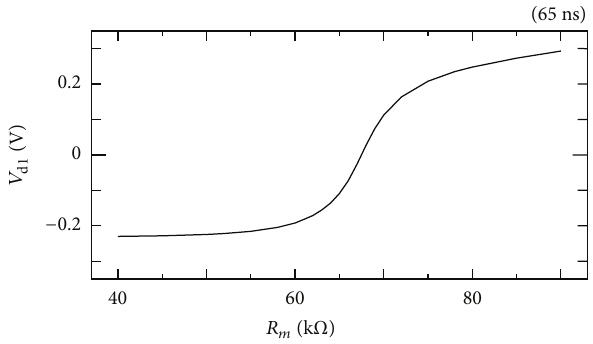
Figure 13: Effect of 𝑅 𝑚 fluctuations. 𝑉 shows the different voltage d1 = 𝑉( S 1)−𝑉( S 2) ). 𝑅 between the node S1 and S2 ( 𝑉 𝑚 was compared d1 , and 𝑅 was fixed at 65 k Ω . 𝑅 𝑚 varied from 40 to 90 k Ω . to 𝑅 refb refb